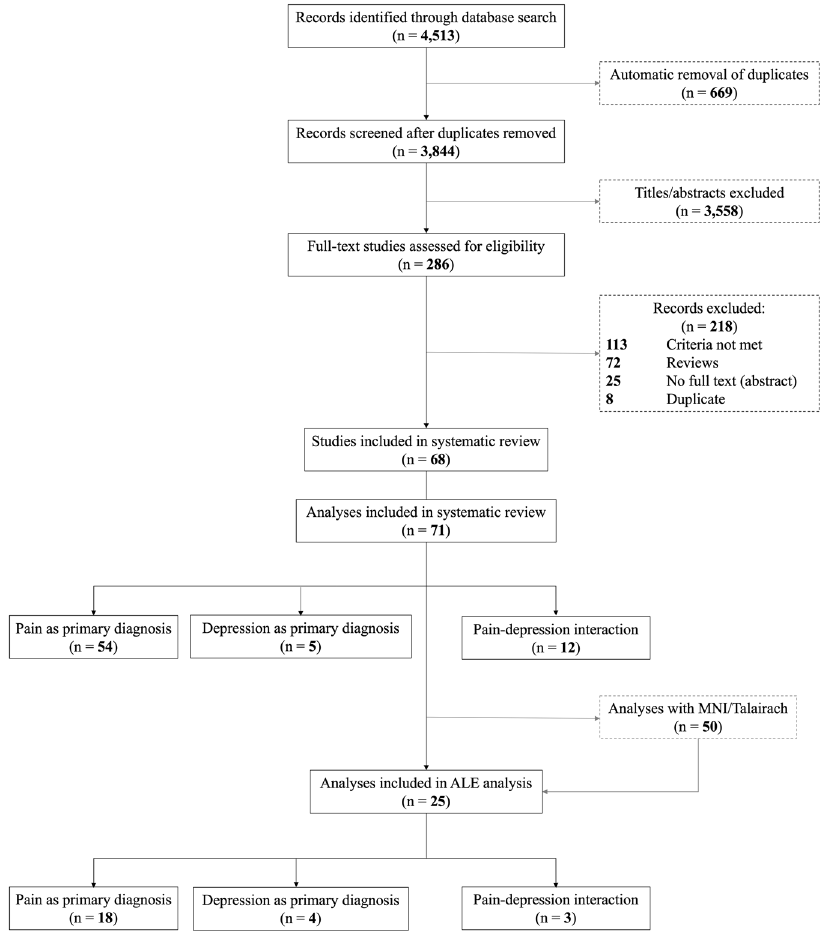
Fig. 1 Process of article selection as per PRISMA guidelines. PRISMA fl owchart (inception to August 2020